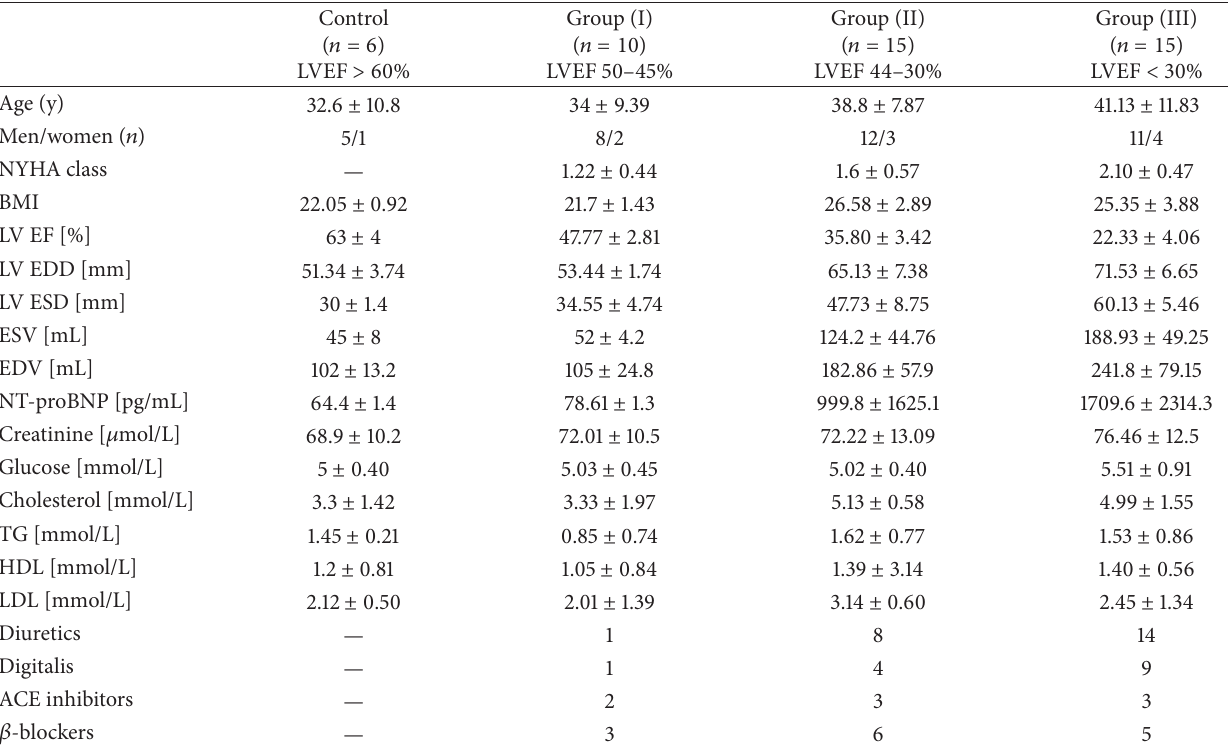
Table 1: Clinical